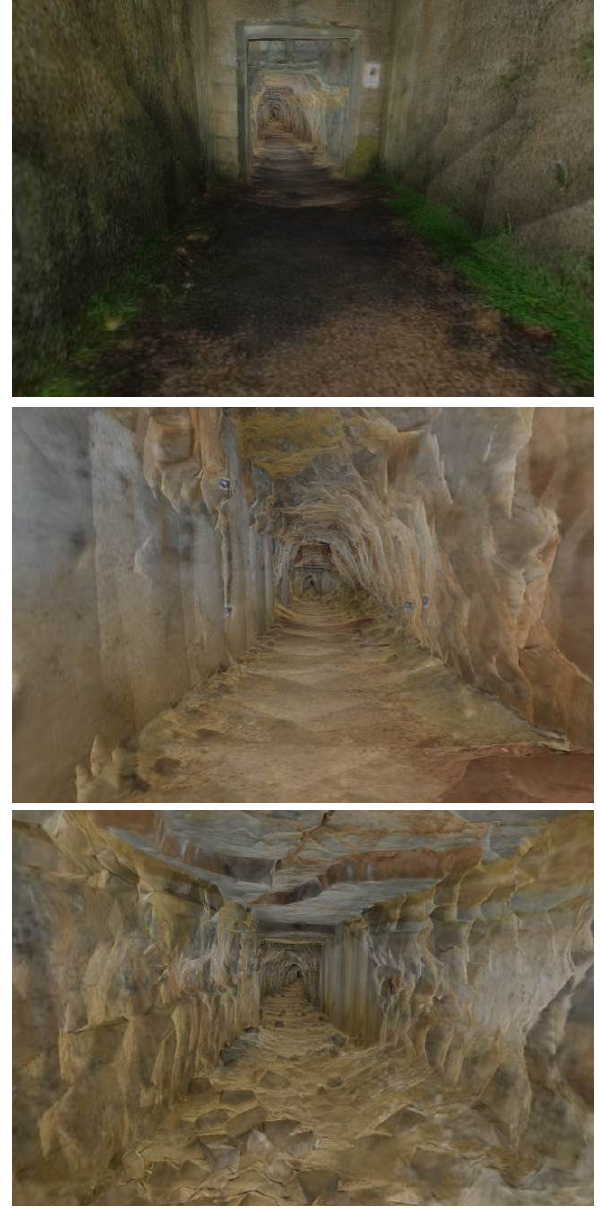
Figure 9. The final photorealistic 3D model of the tunnel, with the texture applied over the sharp optimized 10 cm